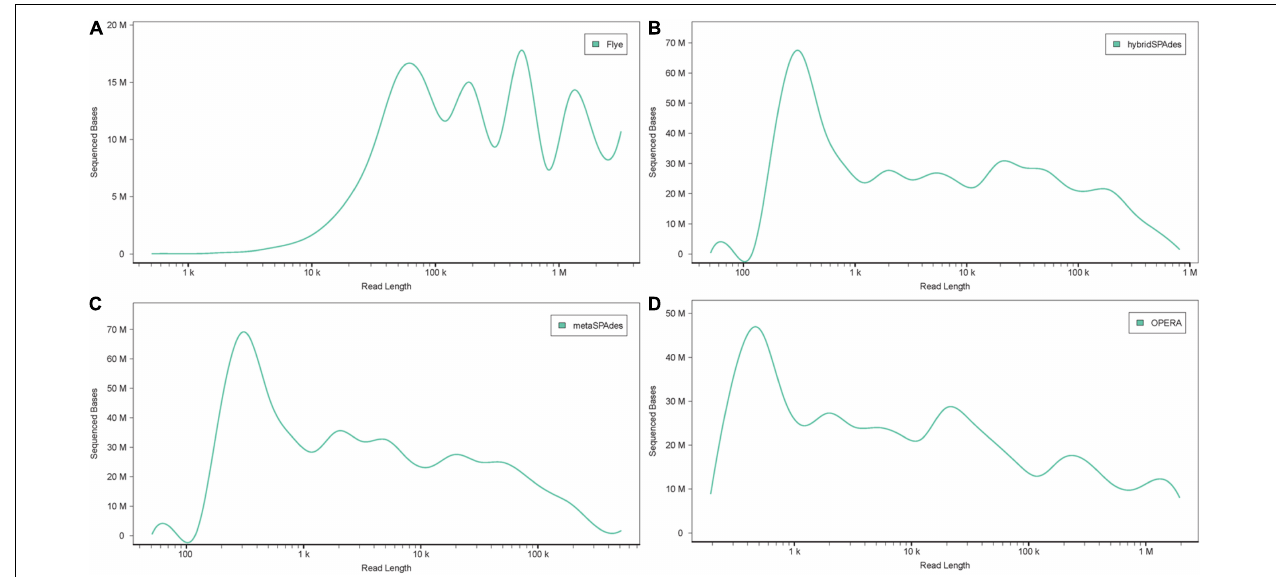
FIGURE 3 | Accumulative distribution of contig length with the four methods: (A) Flye, (B) hybridSPAdes, (C) metaSPAdes, and (D) OPERA-MS. The X and Y axis represent the length (bp) and number of the contigs,